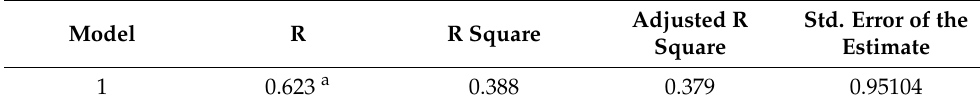
Table 10. Regression 3: SMA and BA.